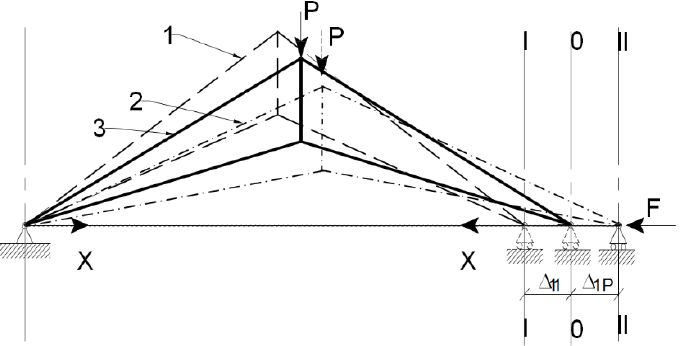
Figure 4. Prestressed arched truss with tie member. (1) Prestressing of the truss by force 𝑋 at the I – I axis; (2) Loading of the truss by force 𝑃 at II – II axis; (3) Restoring of equilibrium by some force at the 0 – 0 axis (neutral axis).